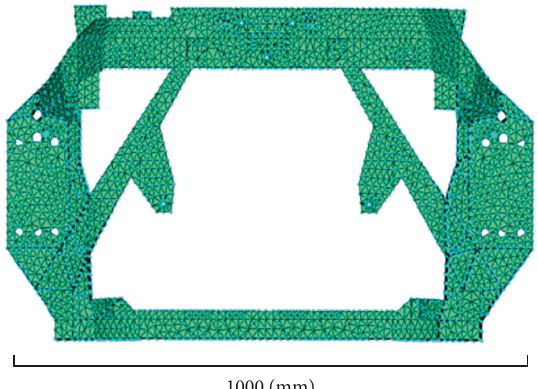
Figure 2: Front-end frame mesh model diagram.